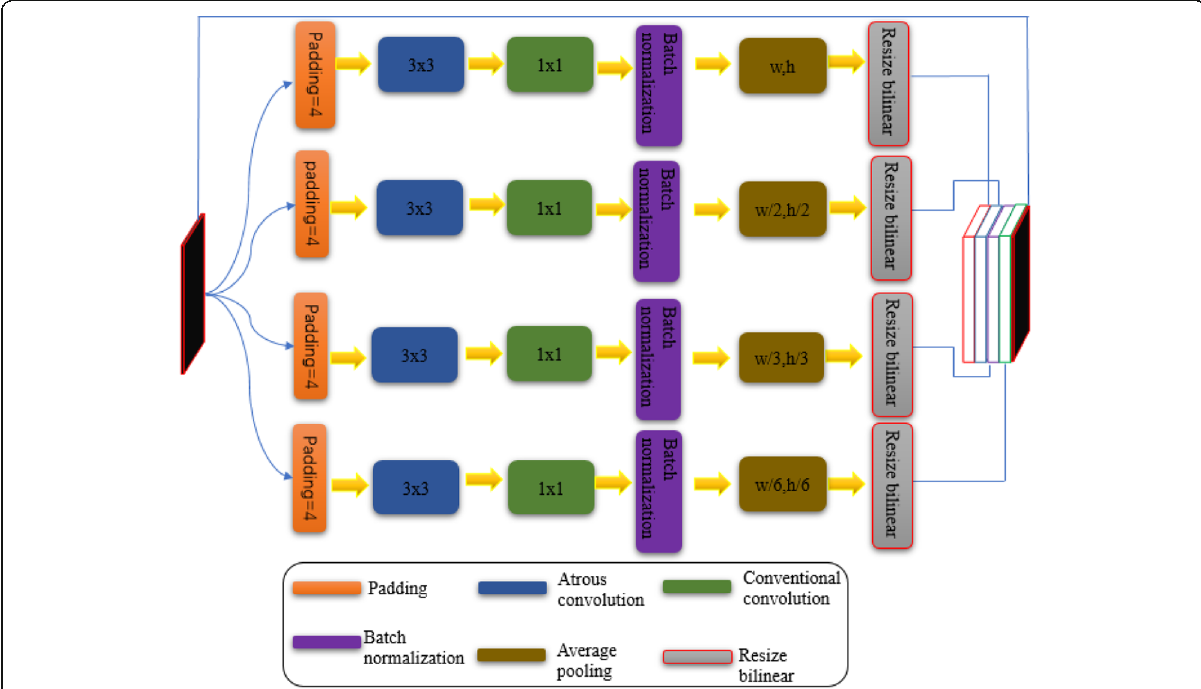
Fig. 2 The internal structure and specific operation of the four-level pyramid